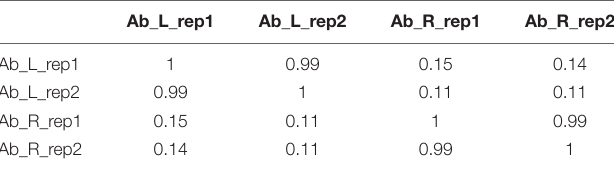
TABLE 1 | Correlation coefficients of transcriptome profiles among RNA-seq samples.